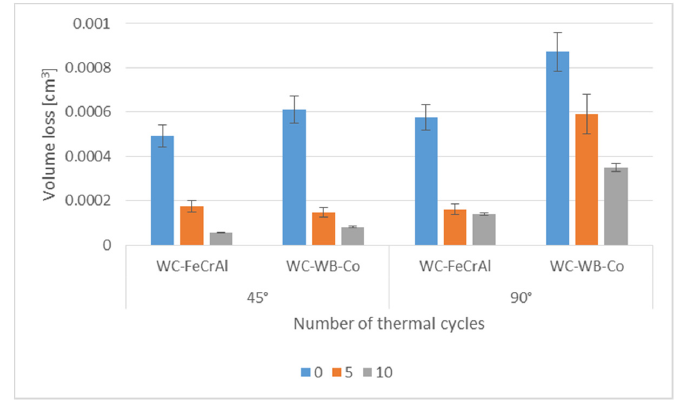
Figure 10. Volume loss of the coatings at particular sample angles.